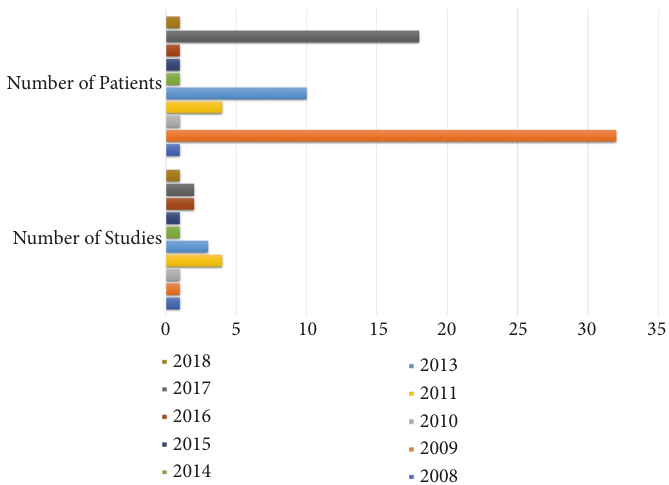
Figure 2: Number of studies and patients per year diagnosed with Pulmonary Embolism through